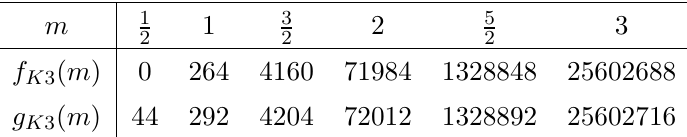
Table 2 . First few values of f K 3 ( m ) and g K 3 ( m ), de(cid:12)ned in (2.11) for a generic K 3 surface.